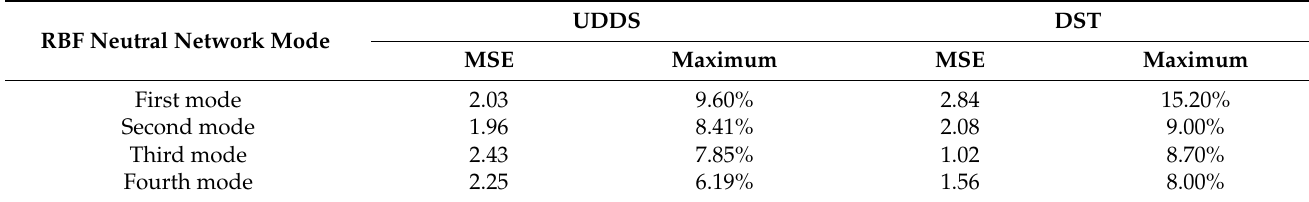
Table 5. Training parameters of the neural network.